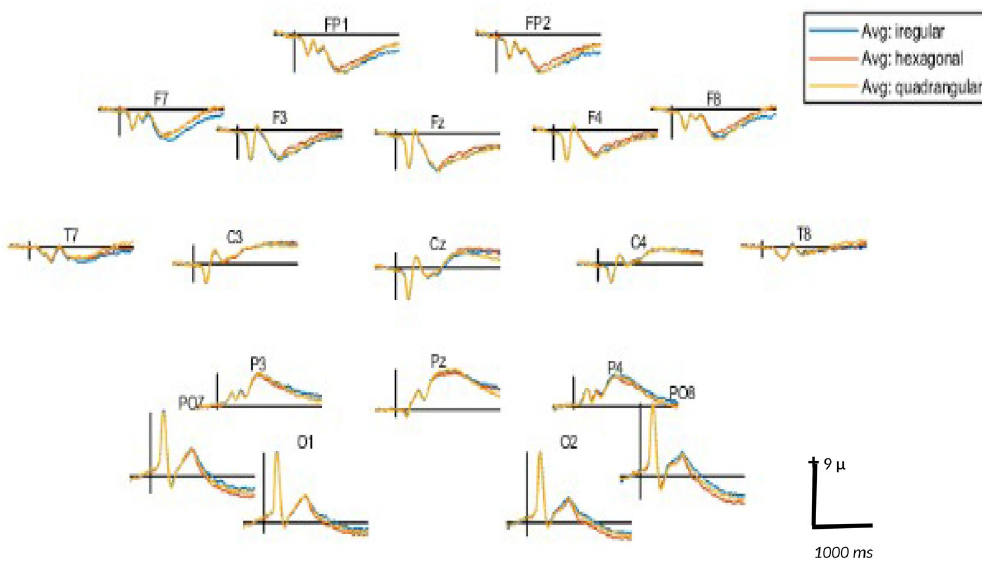
Figure 6. Grand averaged signal in a 19 channel montage for three arrangement displays. Time window: − 200–1000 ms. Positivity is plotted upwards.